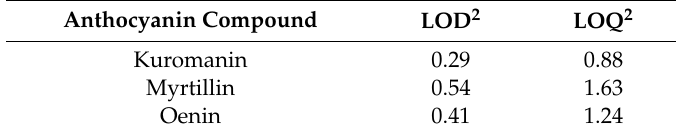
Table 1. Limit of detection (LOD) and limit of quantification (LOQ) values for the HPLC-DAD method. 1